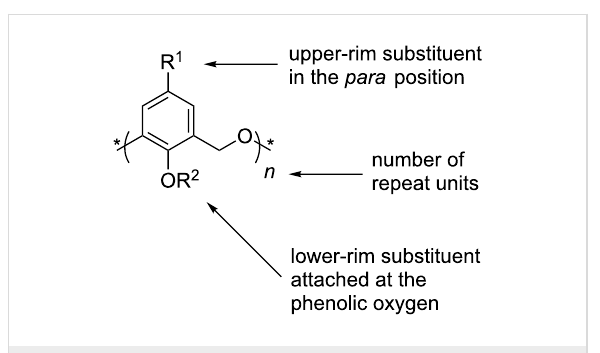
Figure 2: Conventional nomenclature for oxacalix[ n